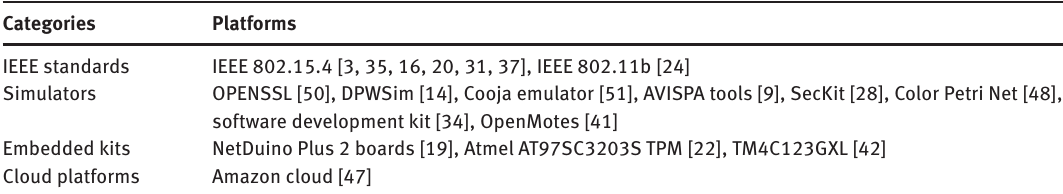
Table 2: Analysis Based on Simulation.